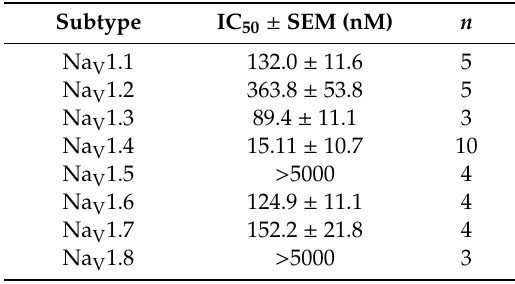
Table 1. Potency of SxIIIC across Na V channel subtypes.